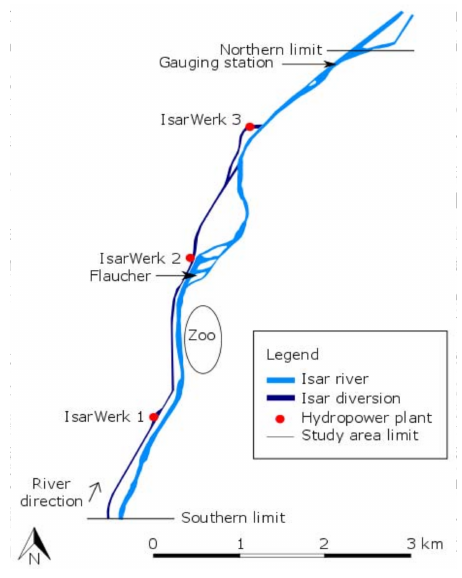
Figure 2. Map of the study area with the location of the hydroelectrical power plants at the Isar side